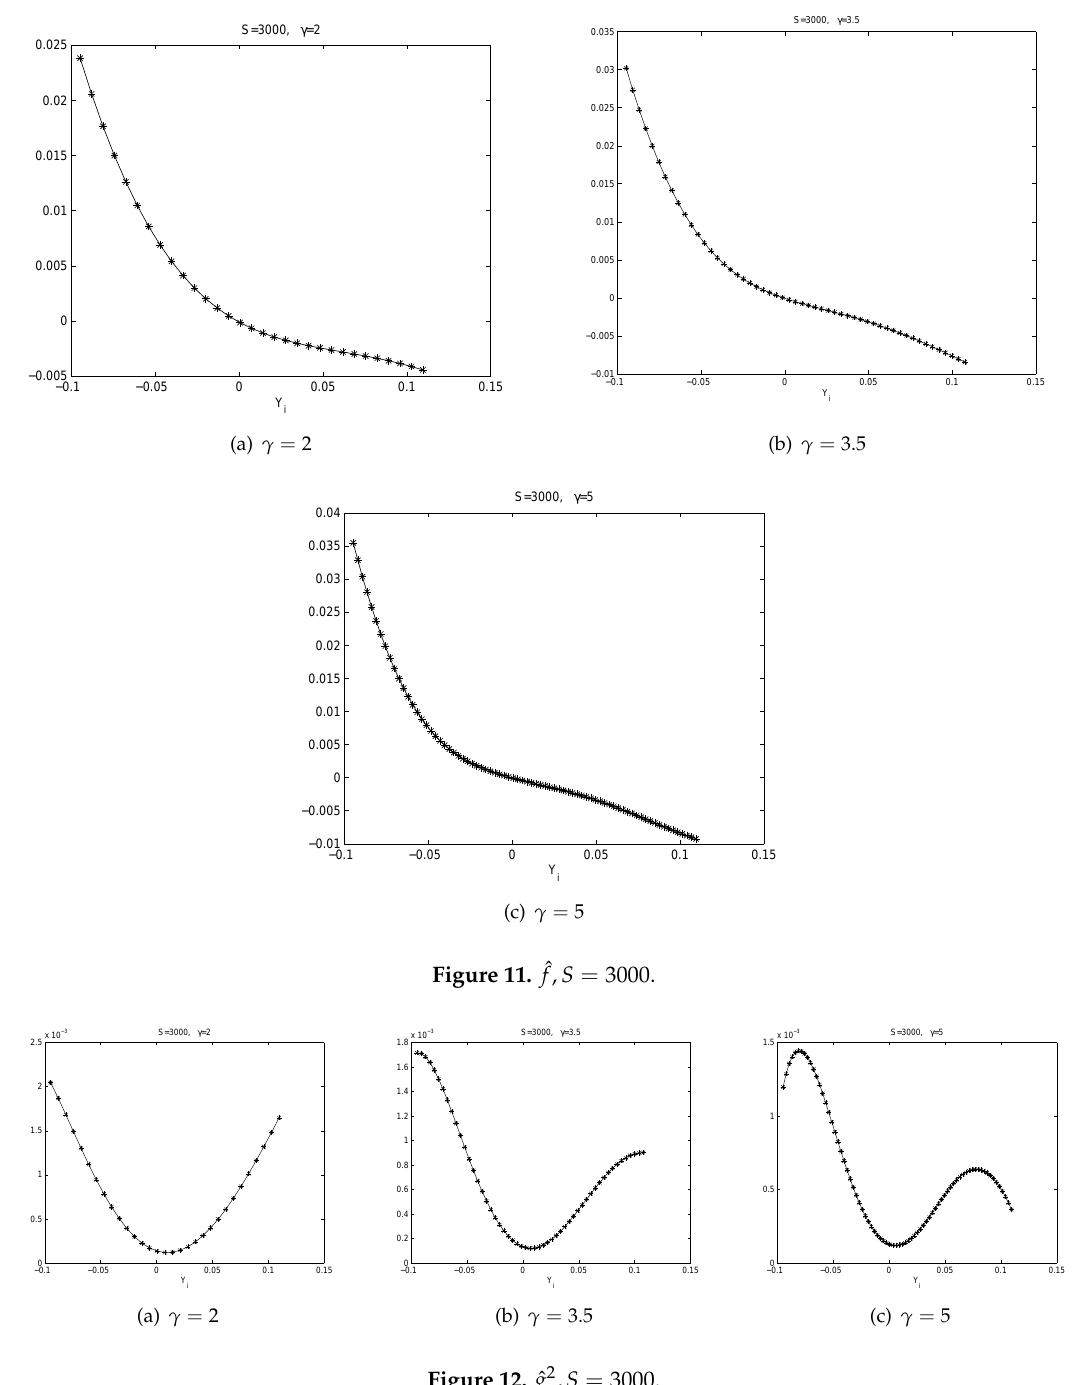
Figure 12. ˆ g 2 , S =